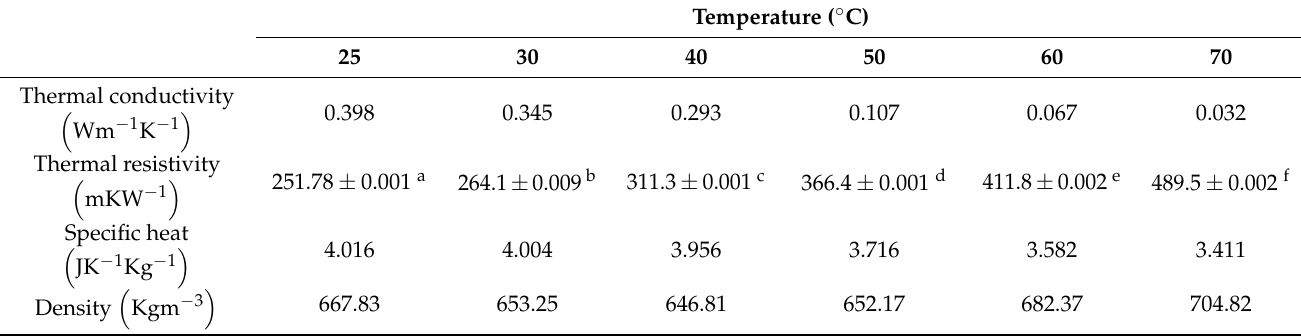
Table 5. Thermal properties and density of 3D-printing rice paste material (sample